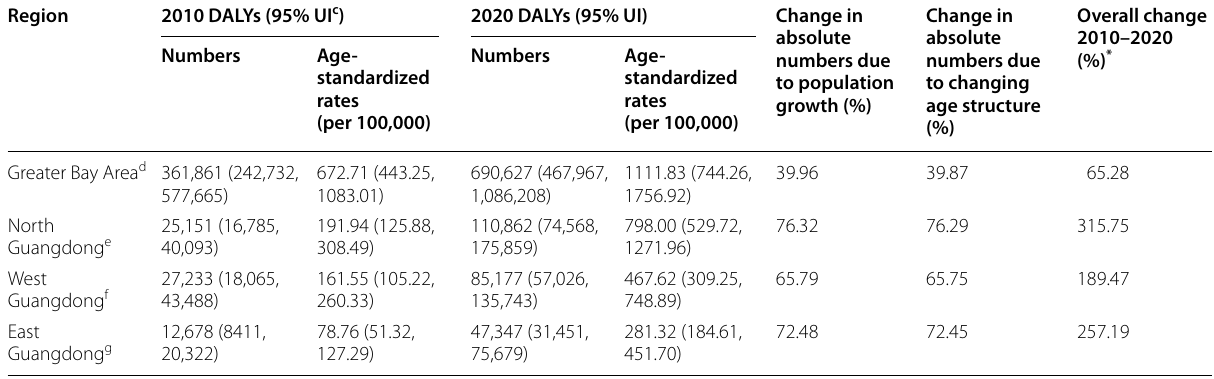
Table 3 Change in absolute DALY a numbers and age-standardized b rates (per 100,000) for patients with severe mental disorders in Guangdong, China, between 2010 and 2020, by economic region